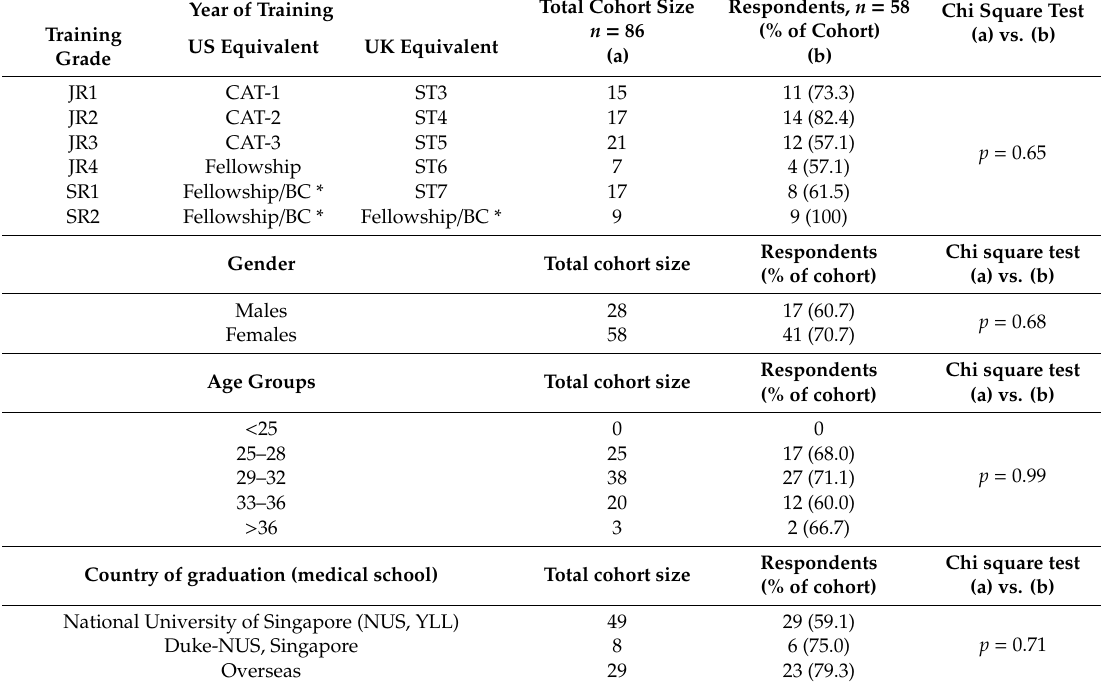
Table 1. Demographics of respondents in relation to the entire cohort of residents in the anesthesiology residency program. * BC denotes board certification or certification for completion of training